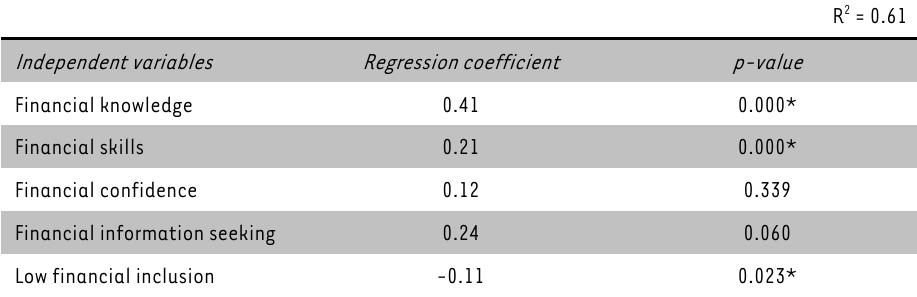
Multiple regression analysis results for the influence of the independent variables on the intervening variable banking and savings behaviour